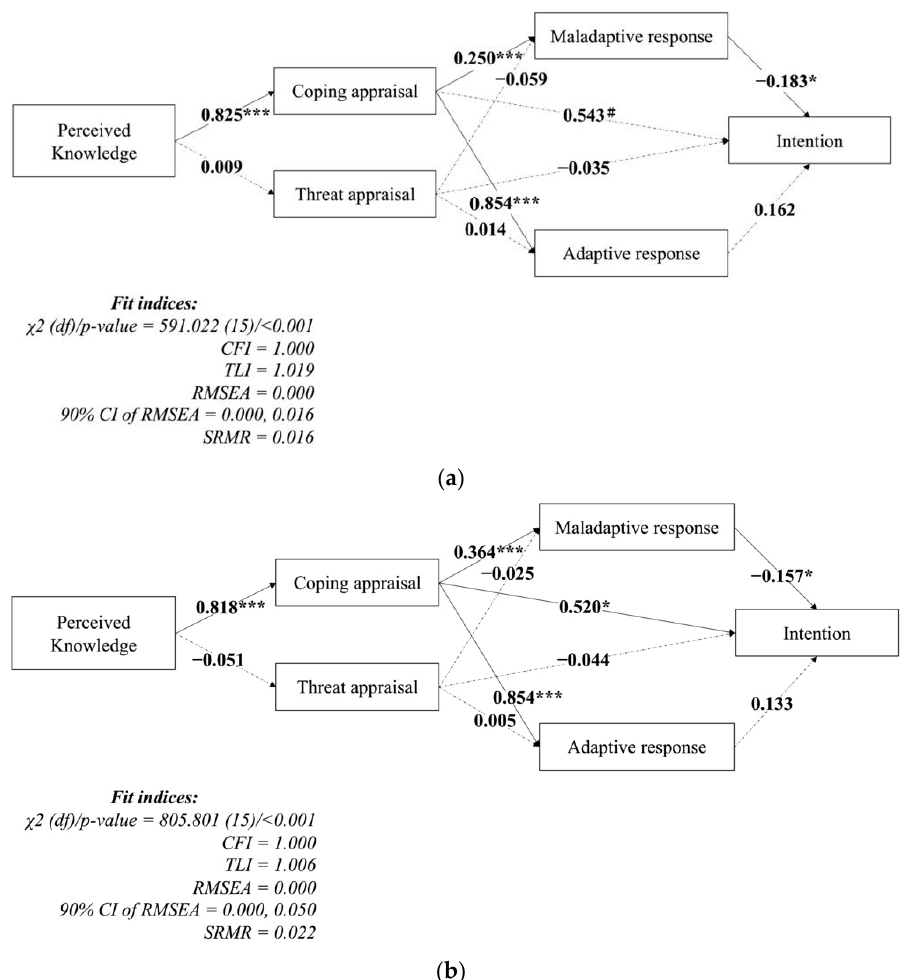
Figure 3. Confirmed model explaining the intention to get COVID-19 vaccination of ( a ) students majoring in medicine-related programs and ( b ) students majoring in non-medicine-related programs. Coefficients are presented using standardized coefficients. Solid lines indicate significant pathways while dashed lines indicate non-significant pathways. * p < 0.05; ** p < 0.01; *** p < 0.001; # p < 0.01. CFI = Comparative fit index; TLI = Tucker–Lewis index; RMSEA = root mean square error of approximation; SRMR = standardized root mean square residual.